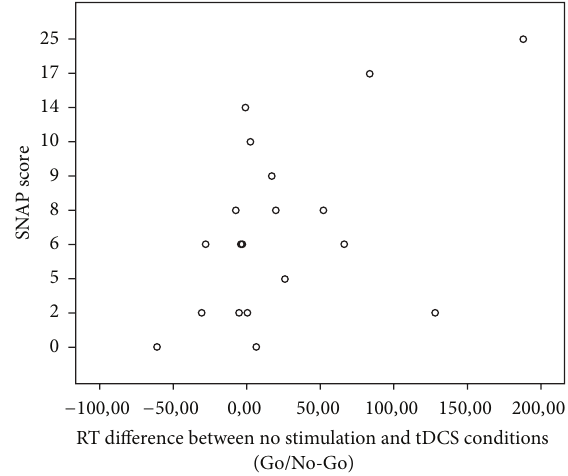
Figure 1: Correlation between SNAP scores and the differences betweenbaselineandtDCSforreactiontimesintheGo/No-Gotask.